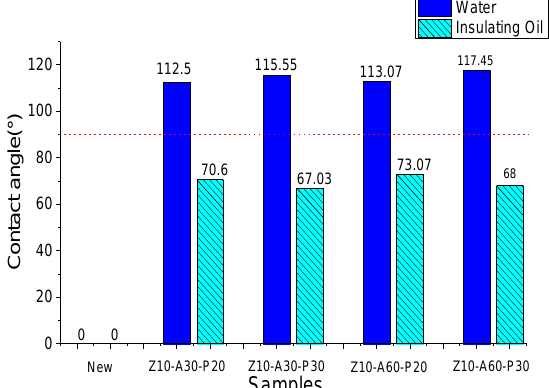
Figure 7. Contact angle of untreated insulating pressboard and modified insulating pressboard to water and mineral oil.